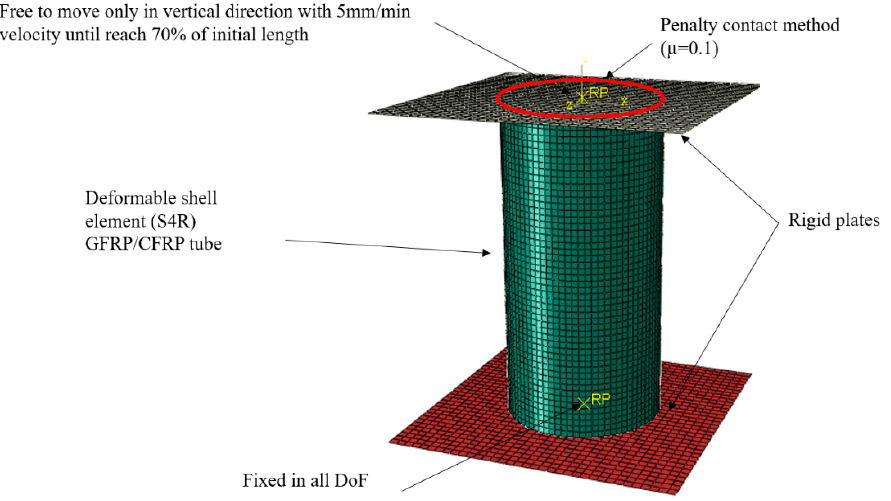
Figure 5. The FE model of the structure under load and the boundary